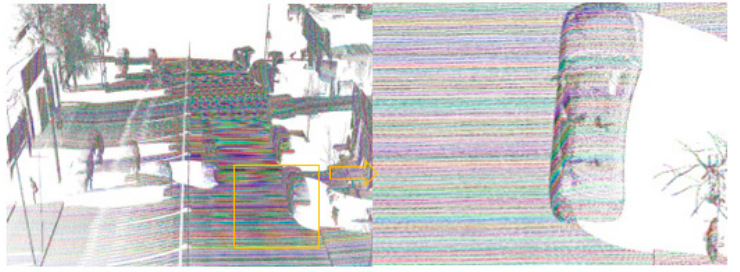
Figure 9. Extraction results for scan lines; different colors represent different scan lines.